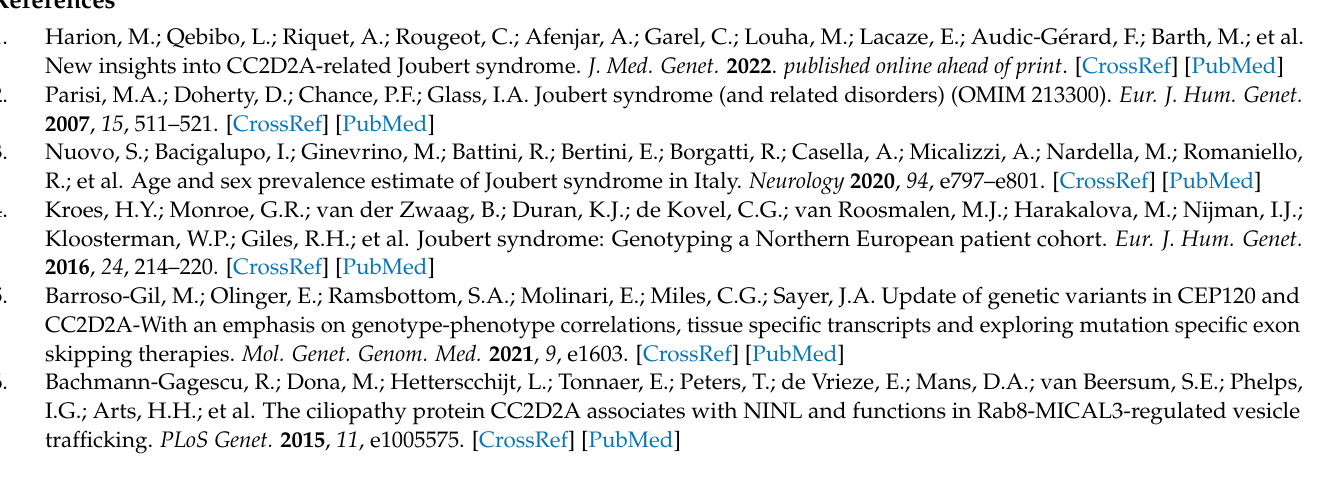
Table S2: Primers used in Sanger Sequencing; Table S3: Primers used in qPCR